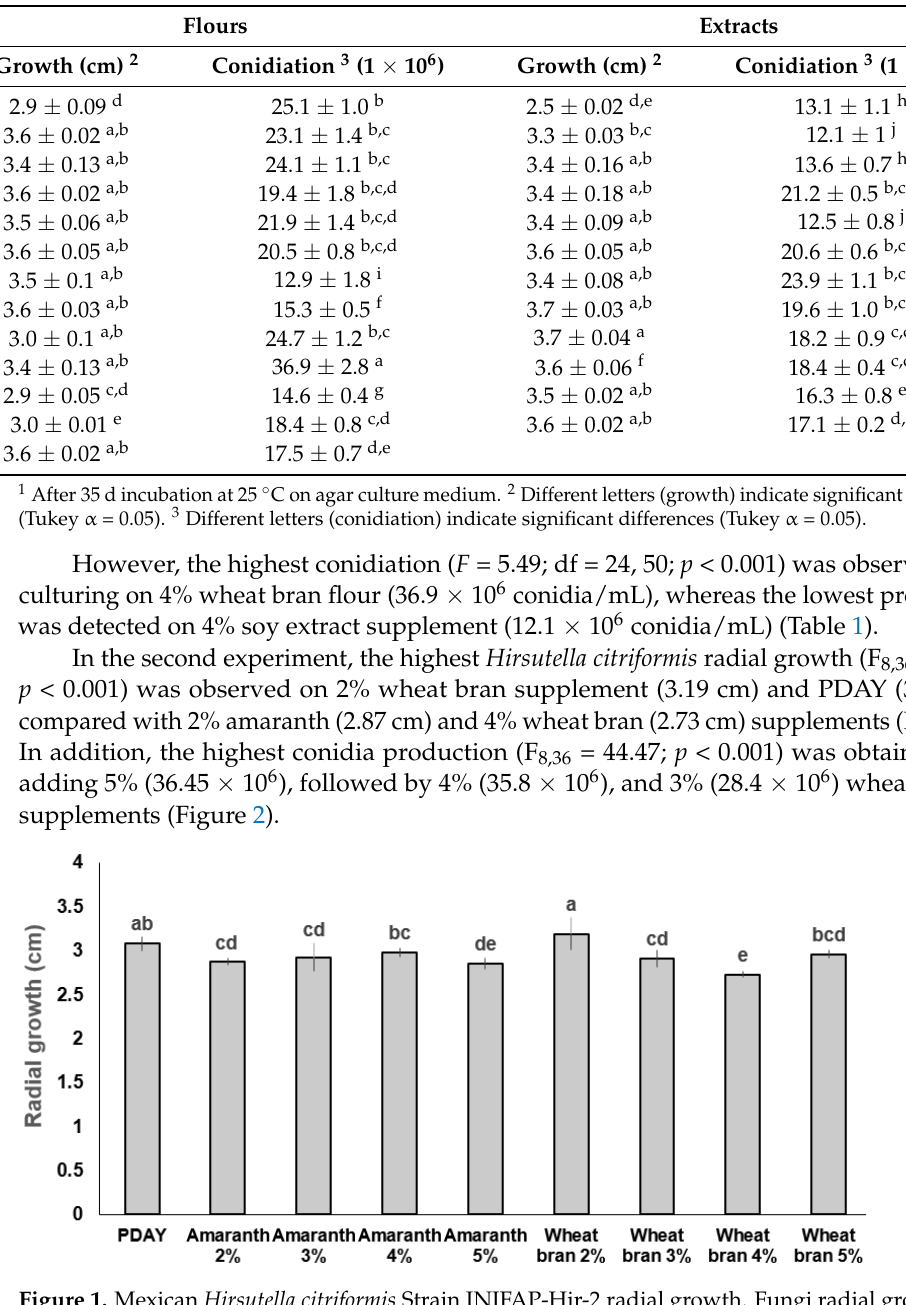
Figure 1. Mexican Hirsutella citriformis Strain INIFAP-Hir-2 radial growth. Fungi radial growth (cm) was measured after 35 d incubation at 25 °C on agar media. PDAY bar represents potato dextrose agar + 1% yeast extract culture. The other bars represent dextrose, peptone, and yeast extract agar (DPYA), supplemented with amaranth or wheat bran at 2%, 3%, 4%, and 5%. Different letters on each column indicate significant statistical differences, and bars indicate the standard error of the mean (Tukey test).